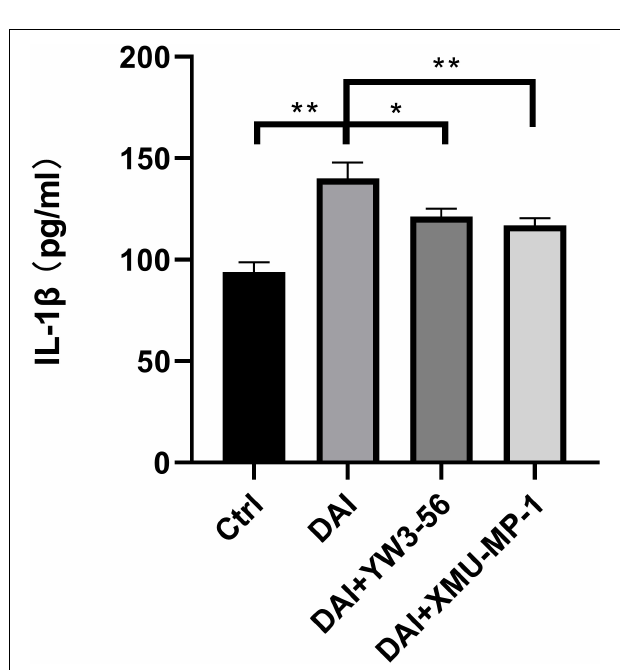
FIGURE 8 | IL-1 β expression in cell supernatant of each experimental group (* P < 0.05 and ** P <